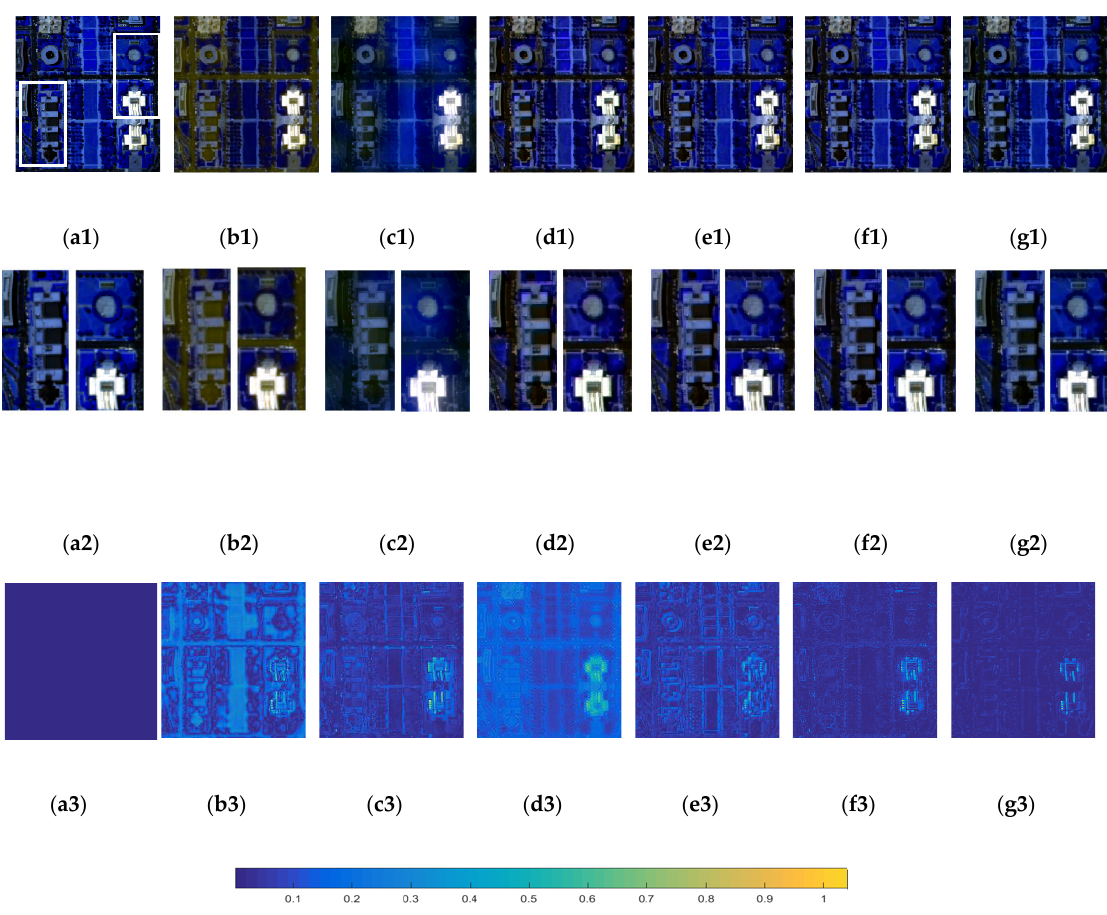
Figure 5. Experimental results obtained by each method for Washington DC dataset. ( a1 – a3 ) Reference image; ( b1 – 3 ) GS; ( c1 – 3 ) GFPCA; ( d1 – 3 ) CNMF; ( e1 – 3 ) HySure; ( f1 – 3 ) Bayesian; ( g1 – 3 ) HFWT. (First row (a1): reference HS image; First row (b1-g1): fused HS images; second row: enlarged subareas; third row